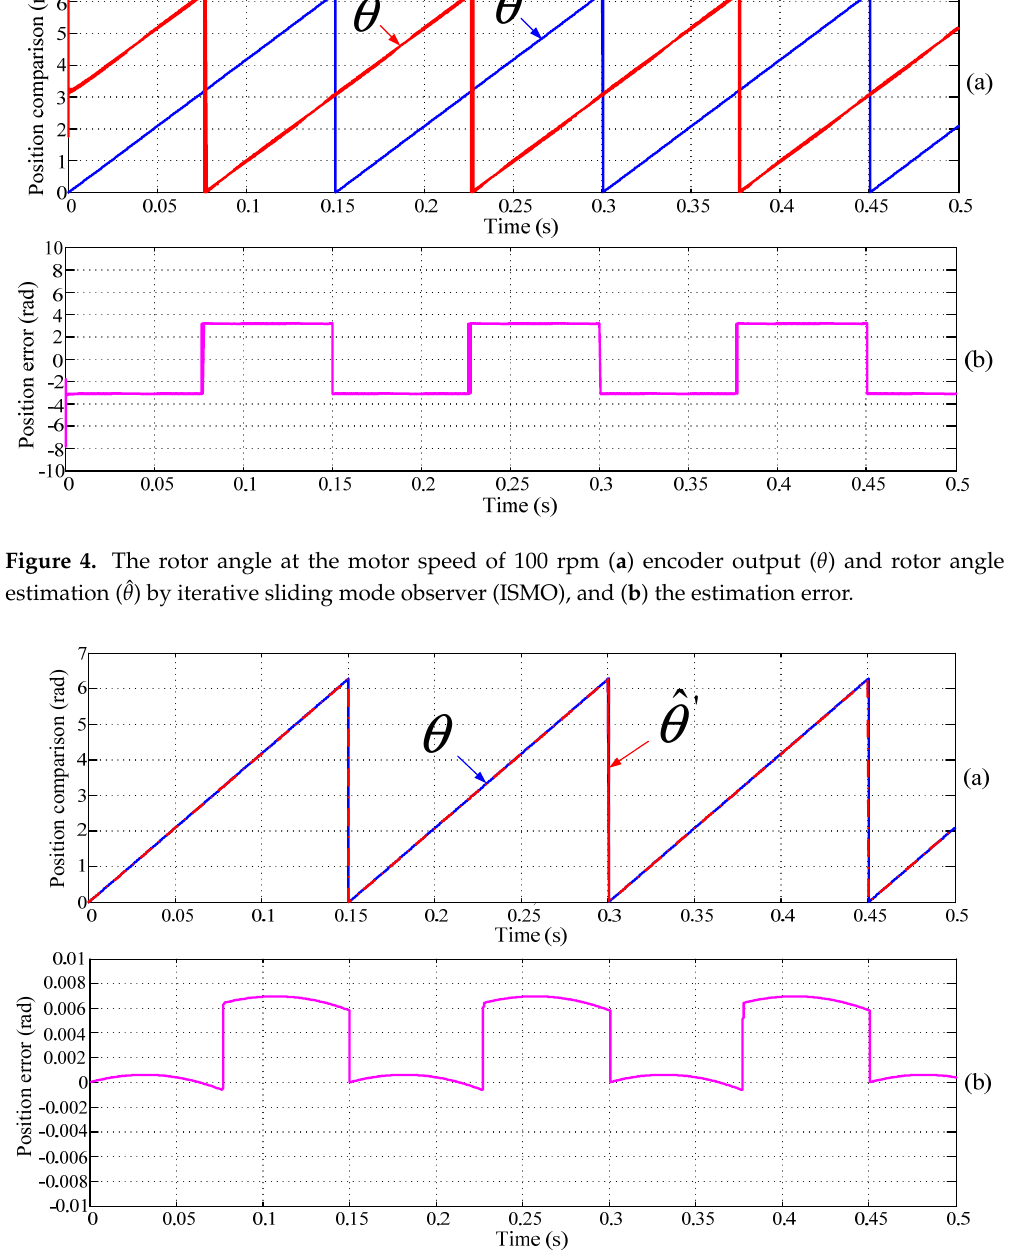
Figure 5. The rotor angle at the motor speed of 100 rpm ( a ) encoder output ( θ ) and rotor angle estimation (ˆ θ (cid:48) ) by NN-ISMO, and ( b ) the estimation